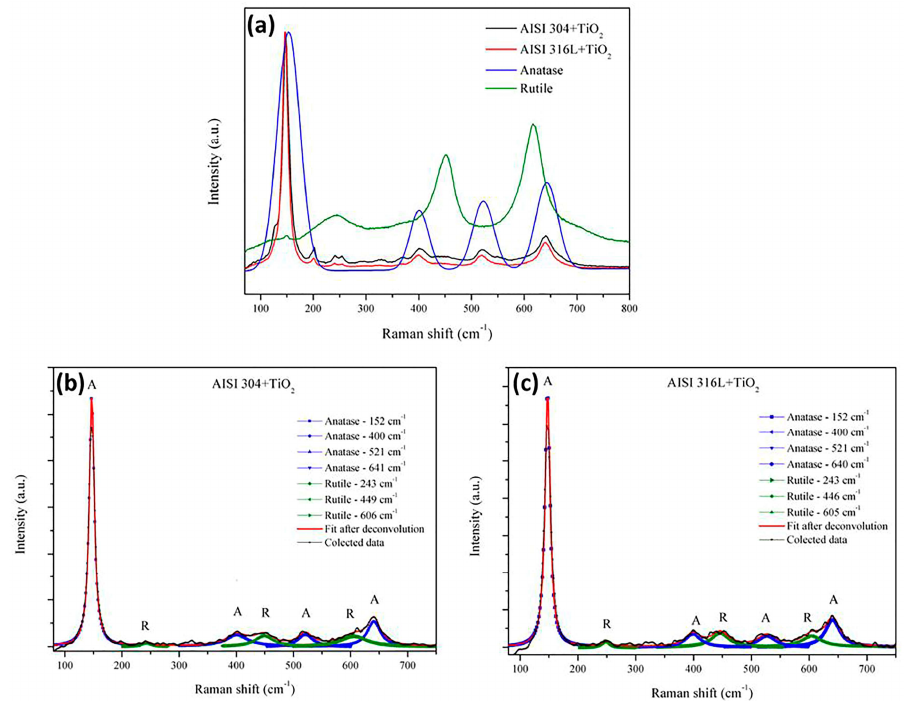
Figure 4. ( a ) Comparison of the Raman spectra for anatase and rutile: the Raman spectra of the TiO 2 films deposited on the AISI 304 and AISI 316L substrates. ( b ) deconvolution bands as reference for anatase (A) and utile (R) phases from TiO 2 film deposited in AISI304. ( c ) deconvolution bands as reference of anatase (A) and utile (R) phases from TiO 2 film deposited in AISI316L.